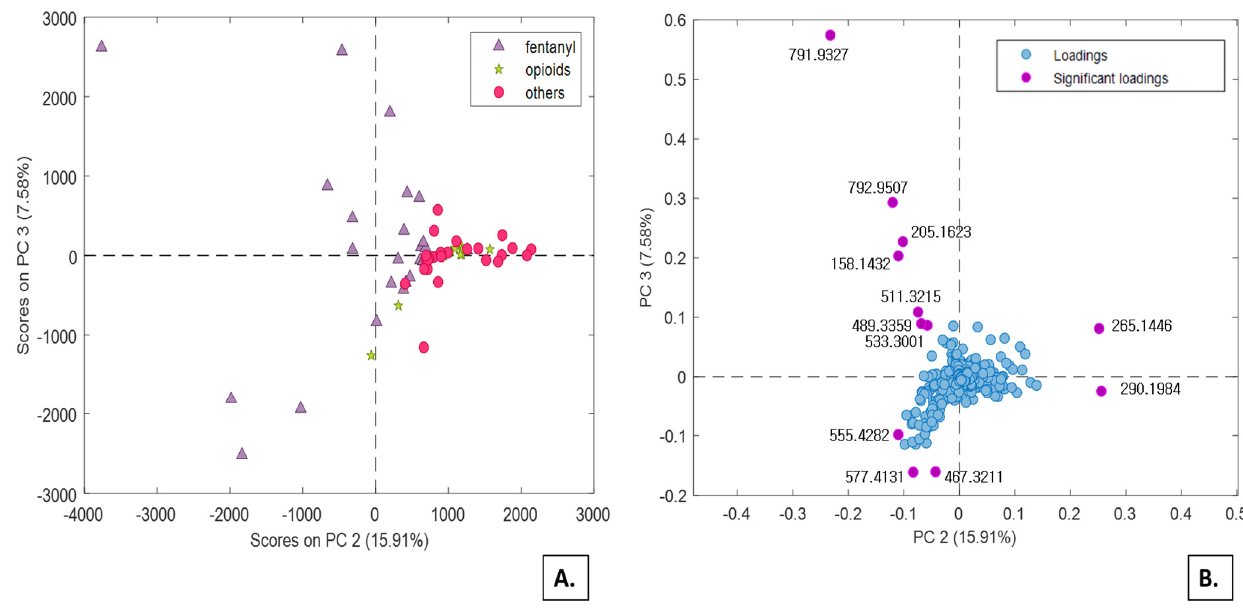
Figure 3. PC2 vs. PC3 scores ( A ) and loadings ( B ) plots from the PCA model calculated on the RP dataset.